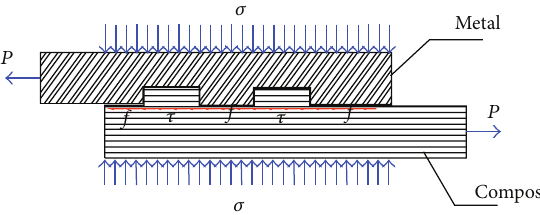
Figure 4: The mechanism diagram of a pretightened tooth connec- tion for